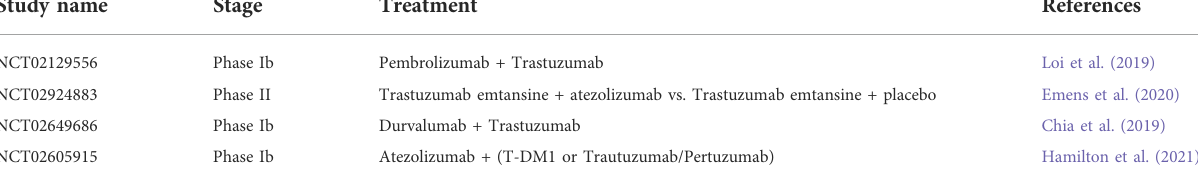
TABLE 2 Clinical trials of immunotherapy combined with anti-HER2